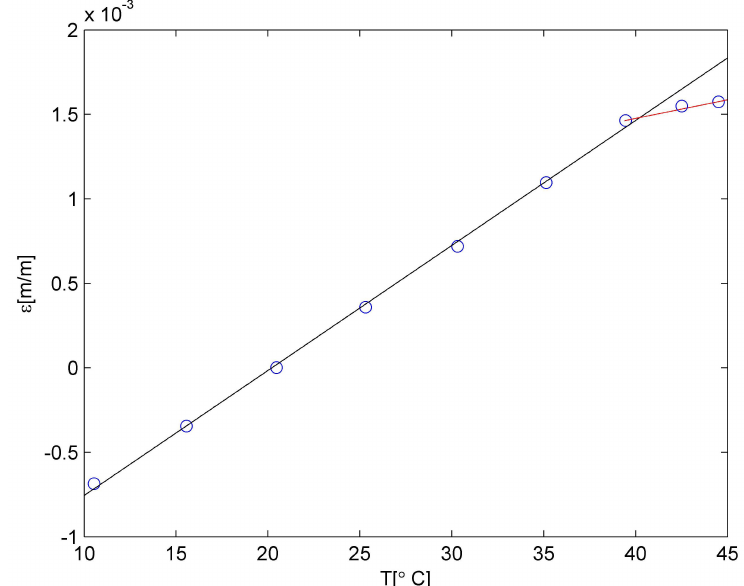
Figure 4. Strain in PLA material due to the temperature